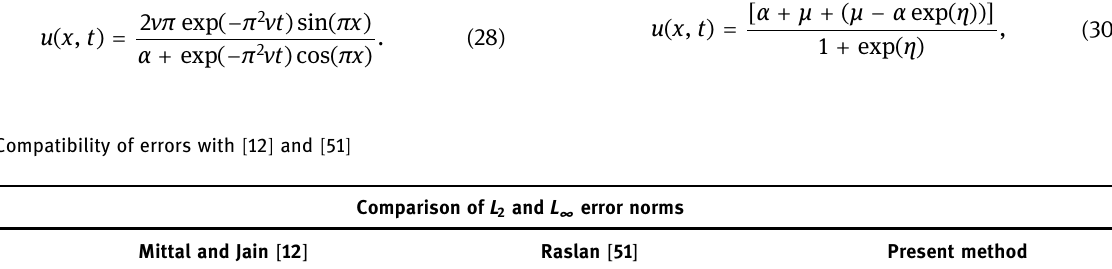
Comparison of L 2 and L ∞ error